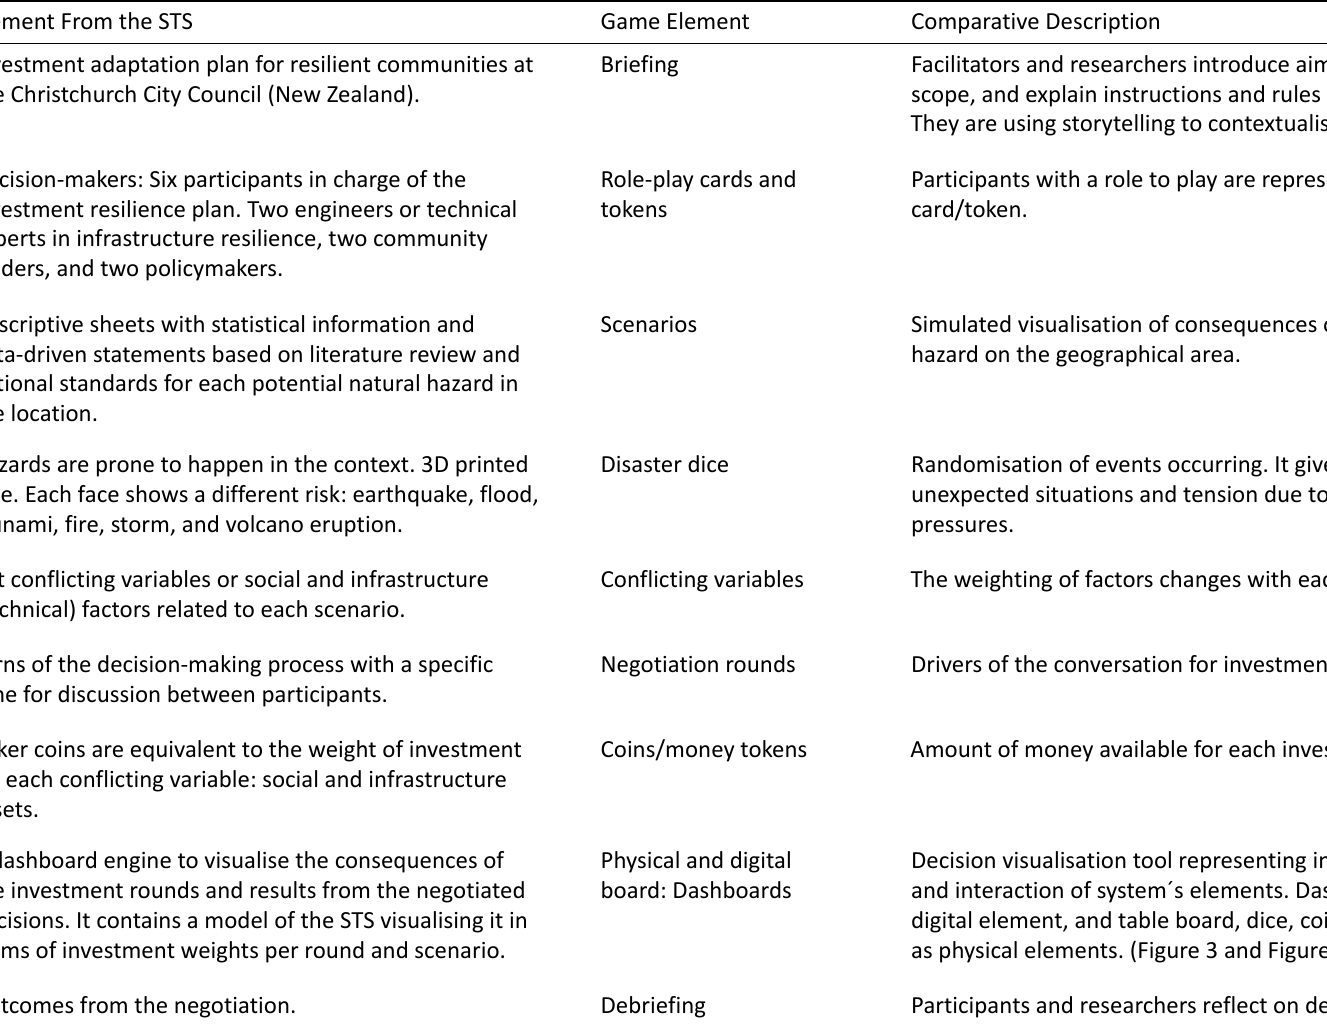
Table 3. Elements from the STS Coastal Protection Plan in Christchurch transformed into game elements in the participatory modelling